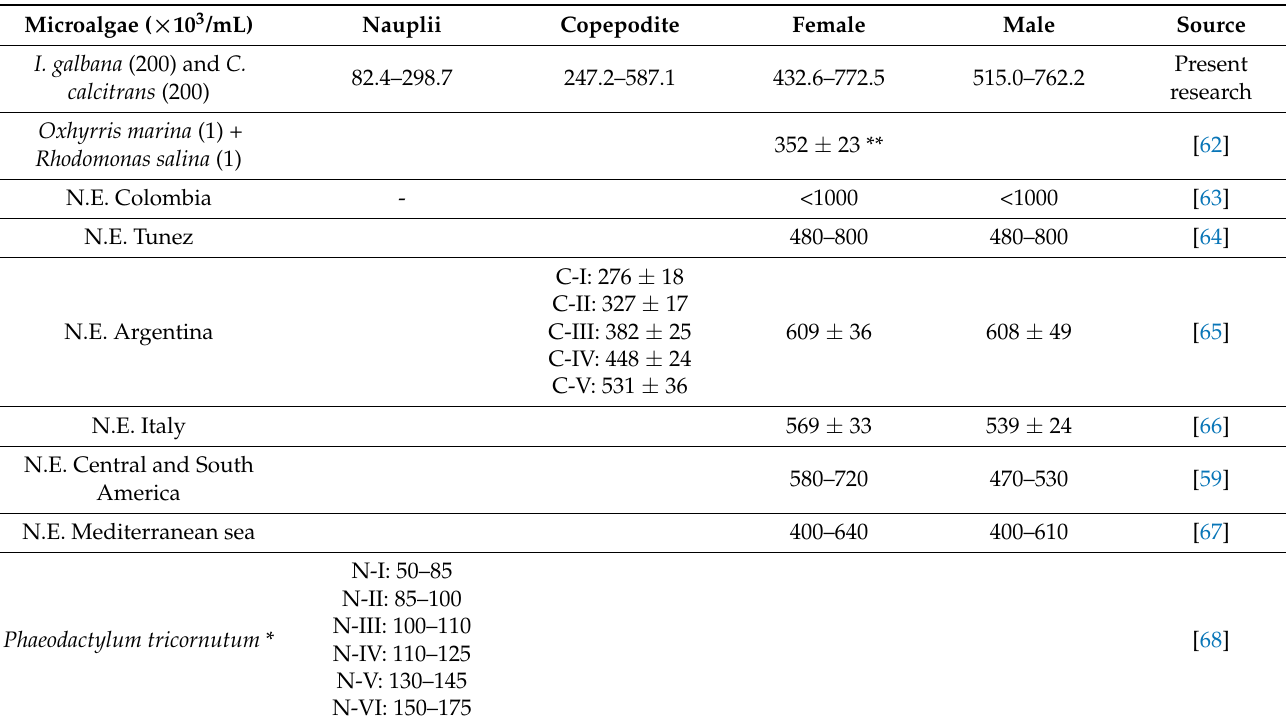
Values (average ± standard deviation). Letters indicate significant differences (a > b, N = 150 per each development stage, n = 5, p < 0.05). Table 4. Oithona nana length comparison ( µ m) fed with experimental microalgae or natural food, in the different development stages, nauplii, copepodites, and females and males. Microalgae ( × 10 3